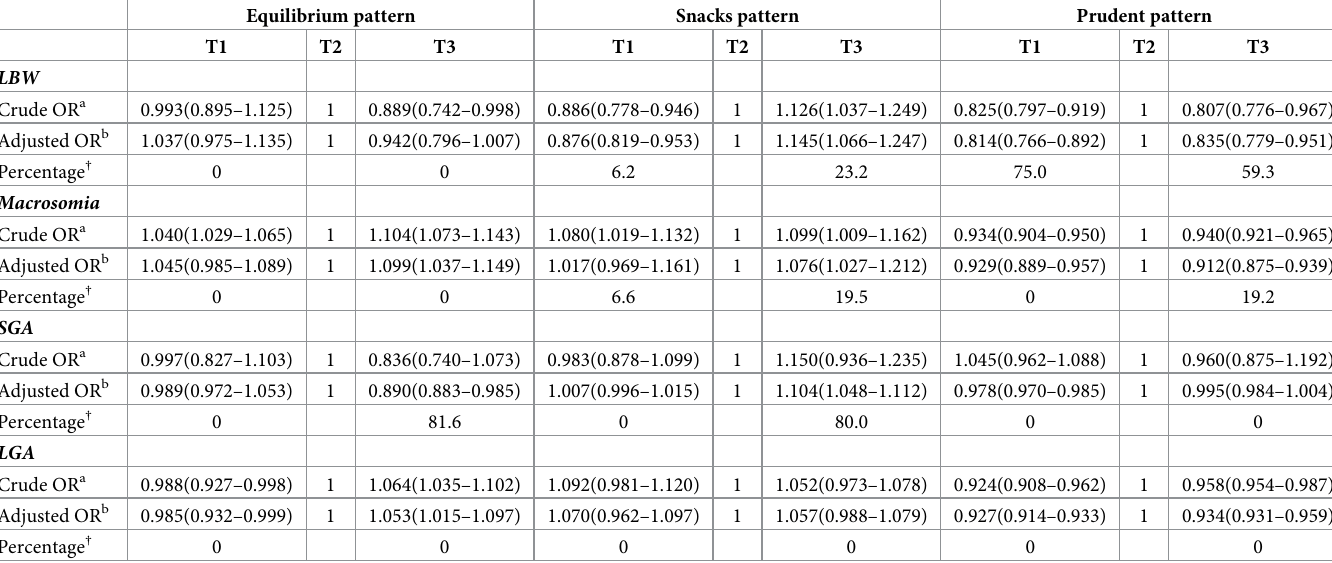
Table 5. The association of dietary pattern with abnormal birth outcomes using the GWR model � . Equilibrium